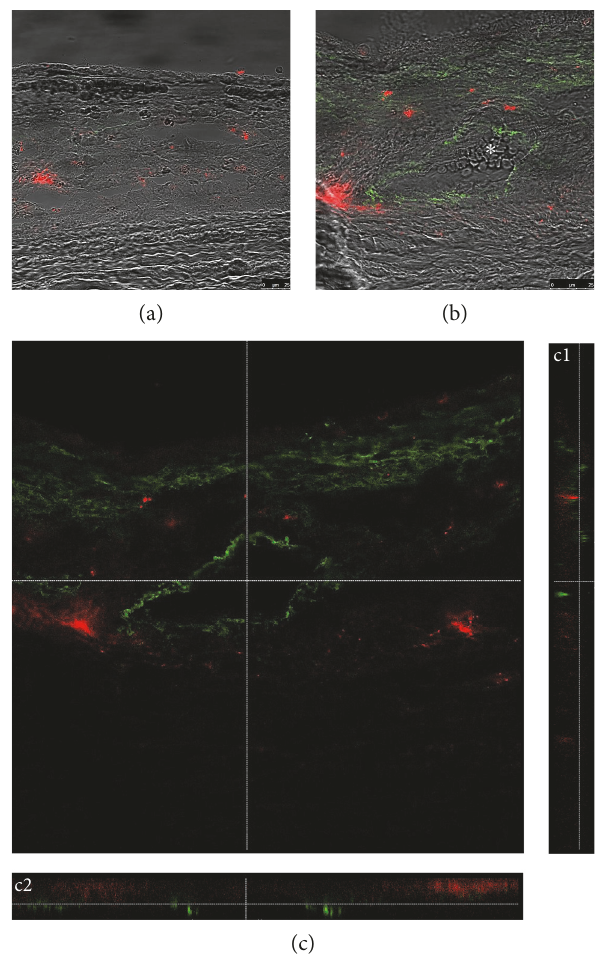
Figure 4: Transplanted hBMSCs are located between the blood vessels in the EVSC. Cross sections of eyes removed 4 days following transplantation of Dil-labeled hBMSCs (red) were stained with an antibody directed against smooth muscle actin (green, (b) and (c)) and photographed using confocal microscopy. (a) The section was incubated without a primary antibody. (b) Dil-labeled cells are clearly identi fi ed across the ECVS. The white asterisk highlights red blood cells inside a blood vessel. Scale bar 25 μ m. (c) A representative confocal image with orthogonal views (c1 and c2) demonstrating the absence of Dil-labeled cells inside the blood